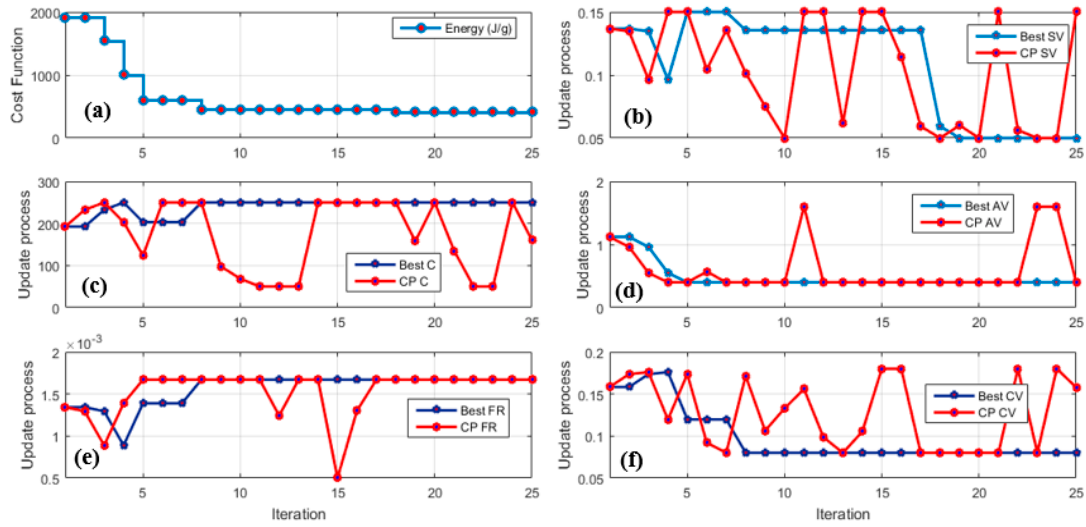
Figure 3. The cost function variation, best values of decision variables during the optimization process of energy per gram. Note: C is the capacitance, CP is the center point, FR is the flow rate, SV is the spacer volume, AV is the applied voltage, and CV is the cell volume. ( a ) the specific energy consumption during the optimization process; ( b ) a decrease of SV; ( c ) increase of the C; ( d ) a decrease in the AV; ( e ) an increase in the FR; ( f ) decrease of the CV.